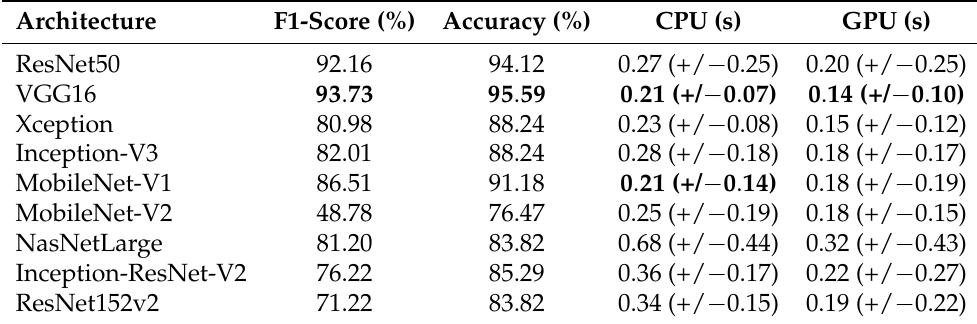
Table 4. Results using the fine-tuning strategy over the nine selected architectures, using the F1- score and accuracy. The time indicates the average computational cost per individual image. Bold highlights the best